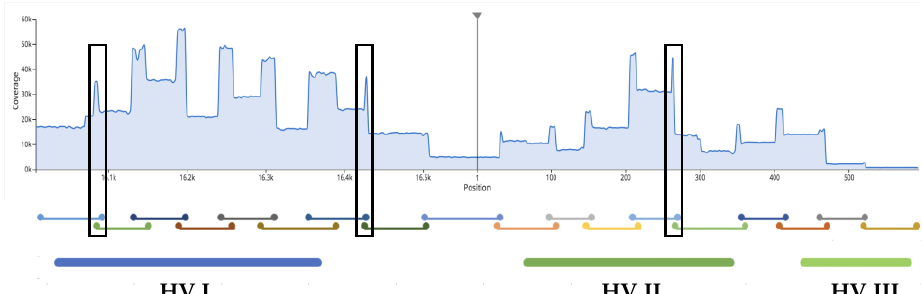
Figure 5. Control region data visualization of Coriell gDNA sample HG03370 as displayed in ForenSeq universal analysis software (UAS) coverage plot (position vs. coverage) with position viewer visible in center at position 0 (vertical line). Tiled amplicons are shown in variously colored horizontal brackets under the coverage plot, as are schematics of hypervariable regions I and II. Three black vertical rectangles show examples of “bat ears” or regions of coverage generated between overlapping